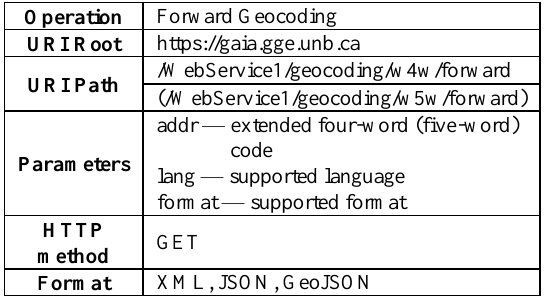
Table 3. Extended w3w forward geocoding API reference